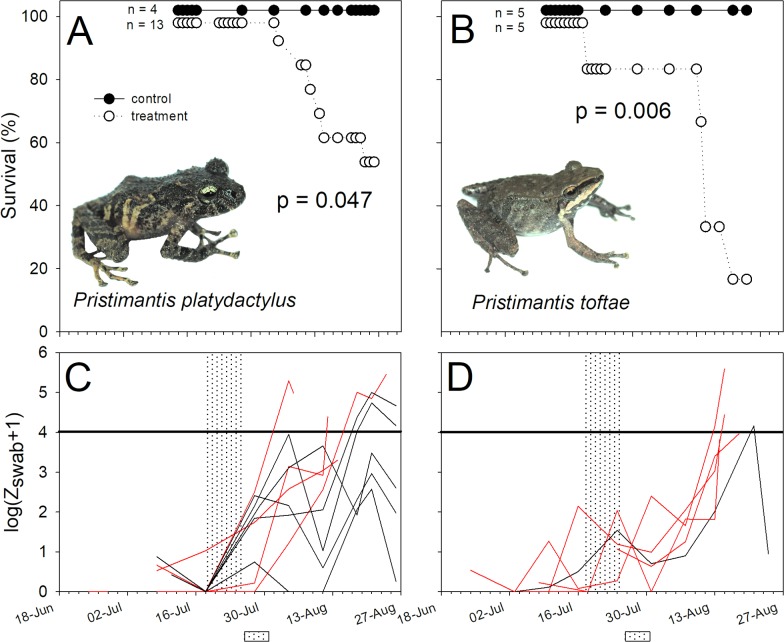
Differences in survival and Bd infection intensity in two susceptible species of terrestrial-breeding frogs, Pristimantis platydactylus and Pristimantis toftae (Craugastoridae).(A, B) Percentage survival, and (C, D) variation in log-transformed zoospore equivalents (Bd infection intensity) of Bd-exposed individuals of Pristimantis platydactylus (left panels) and P. toftae (right panel). See Fig 2 for caption details.